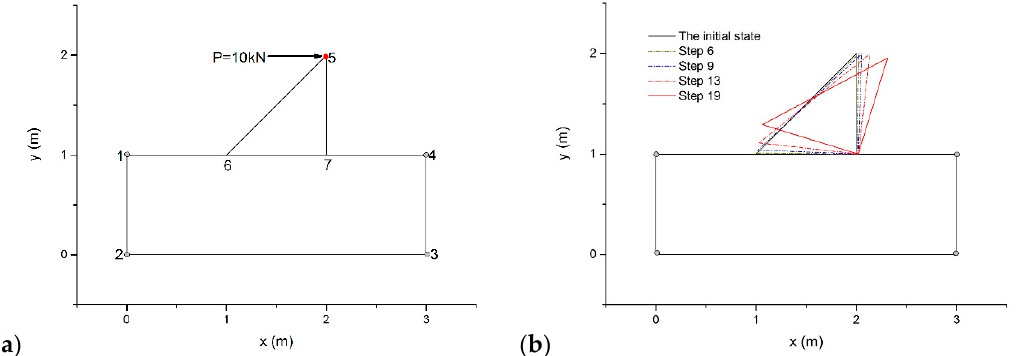
Figure 6. ( a ) A triangular block on the foundation and ( b ) its movement under a horizontal point load.